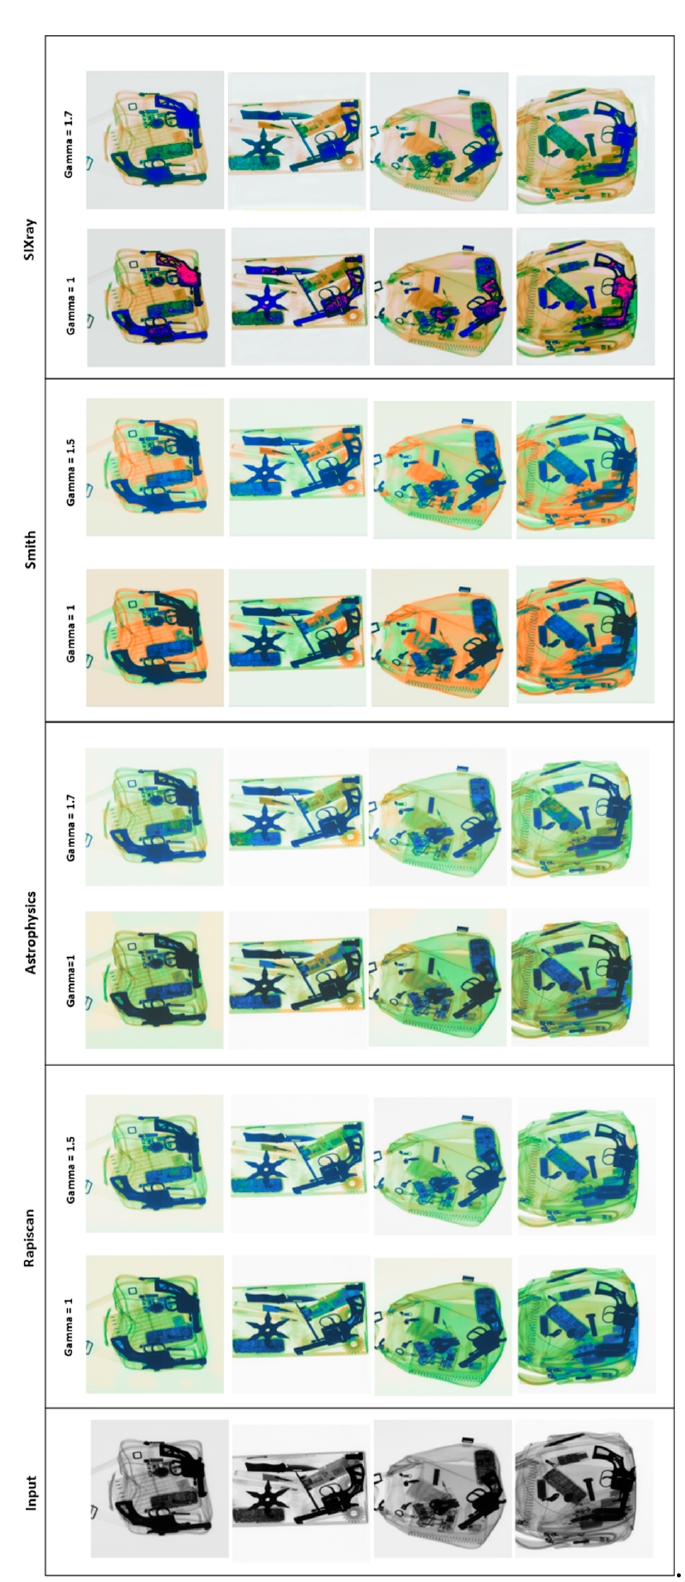
Figure 7. Quality results were obtained by applying the proposed models on single-energy X-ray images. Each row consists of input single-energy image (grayscale), Rapiscan-, Astrophysics-, Smith-, and SIXray-based colorization results with a gamma value of 1. and the best gamma value for each scanner.